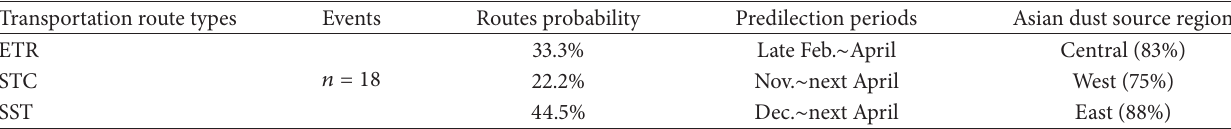
Table 1: The transportation types and soil sources of 18 ADS events in this